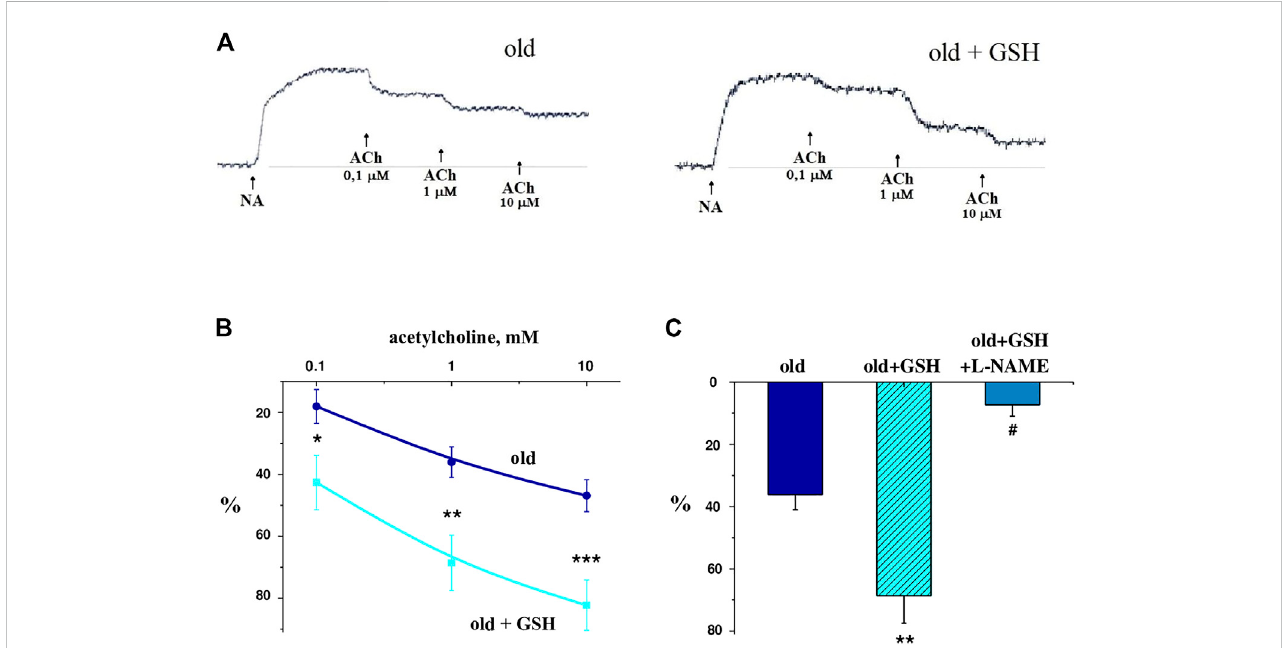
FIGURE 5 Vascular preparations relaxation in response to different doses of acetylcholine against the background of norepinephrine-induced vasoconstriction of GSH-treatedanduntreatedoldrats: (A) nativecurves; (B) dose-dependentcurves; (C) relaxationofisolatedaortaringsinresponsetoacetylcholine(1 μ mol/L) in old rats, old GSH-treated and old GSH-treated rats background of L-NAME (100 μ mol/L). Data are represented as mean ± SEM; n = 7 – 8. * r = 0.047 versus old; ** r = 0.017 versus old; *** r = 0.0077 versus old; # r = 0.0026 versus old + GSH as calculated by ANOVA